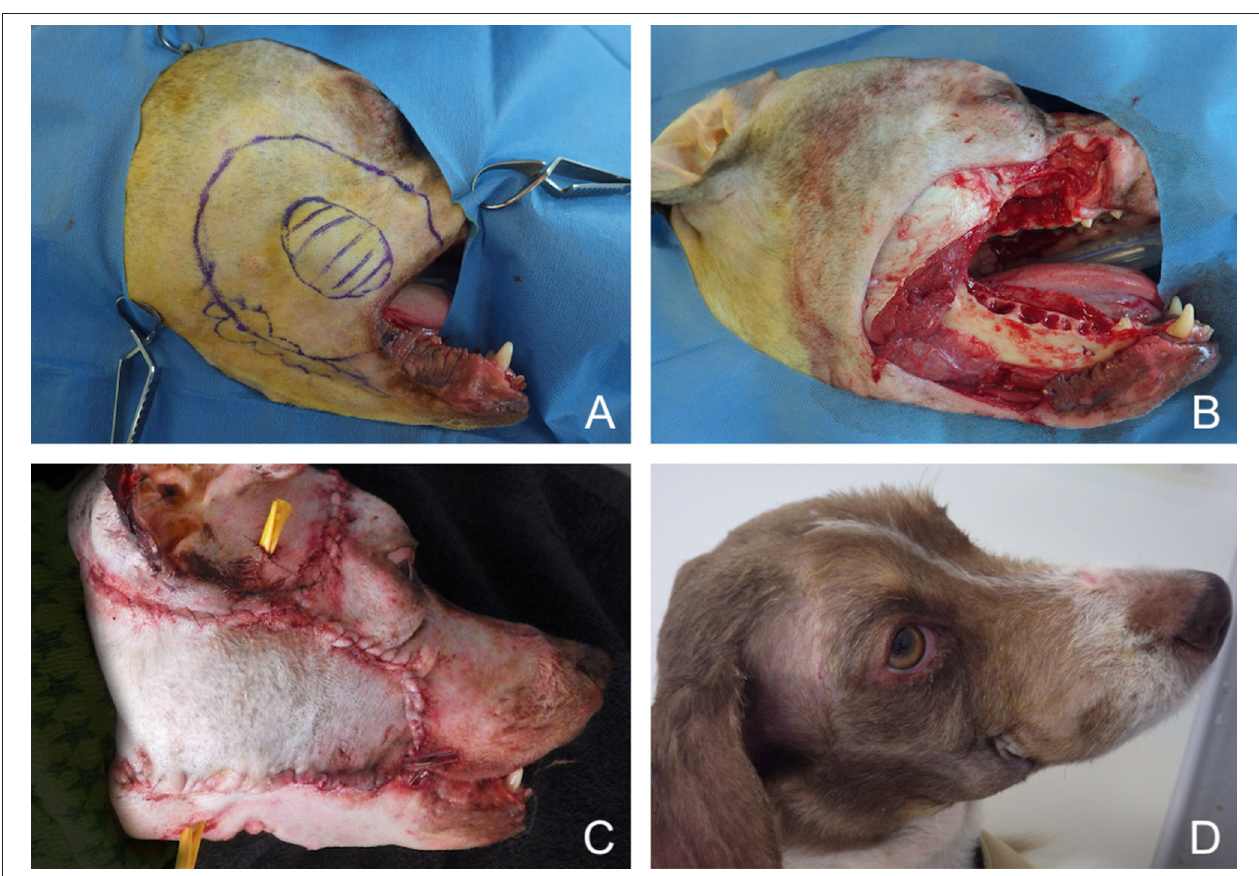
FIGURE 11 | Closure of a large facial composite defect with a superficial temporal myocutaneous axial-pattern flap in a dog with an invasive oral malignant melanoma. (A) Surgical planning. (B) Peri-operative aspect after removal of the cheek, caudal maxilla. (C) Immediate postoperative aspect. (D) 1.5-months postoperative